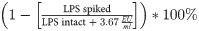
The distribution of LPS-neutralizing capacity (LPS-NC) of stroke cases and controls.Serum samples of cases (n = 98) and controls (n = 100) were spiked with 3.67 EU/ml of E. coli LPS and the LPS-neutralizing capacity of the serum was calculated as (1−[LPSspikedLPSintact+3.67EUml])*100%.